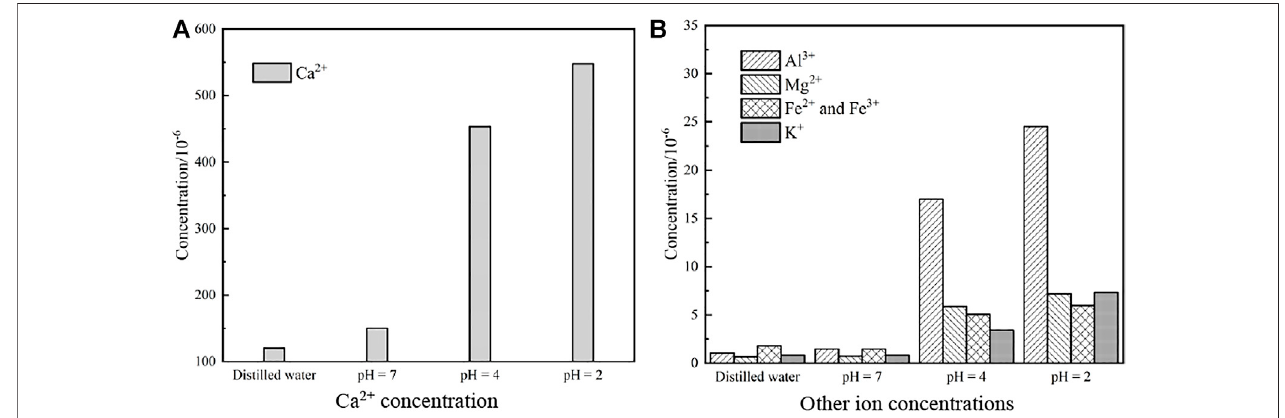
FIGURE 11 | Detection results of ion concentration in aqueous chemical solution after saturation. (A) Ca 2+ concentration. (B) Other icon concentration.